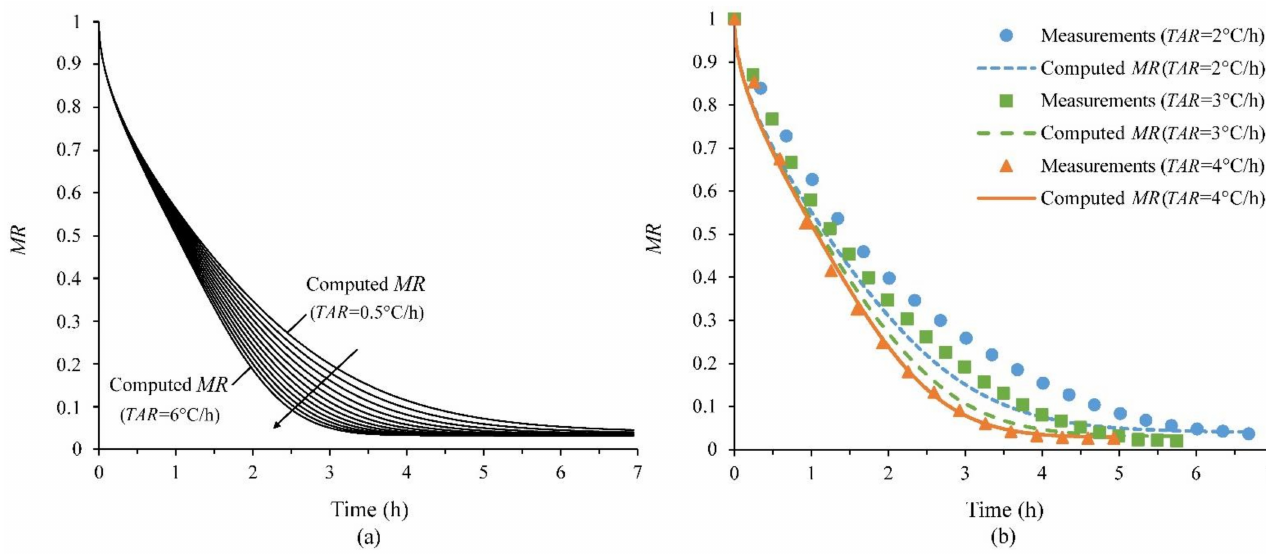
Figure 3. ( a ) Measured and computed moisture ratio ( MR ) of lavender, ( b ) Computed MR for TAR = 0.5–6 ◦ C/h with a 0.5 ◦ C/h step at 2